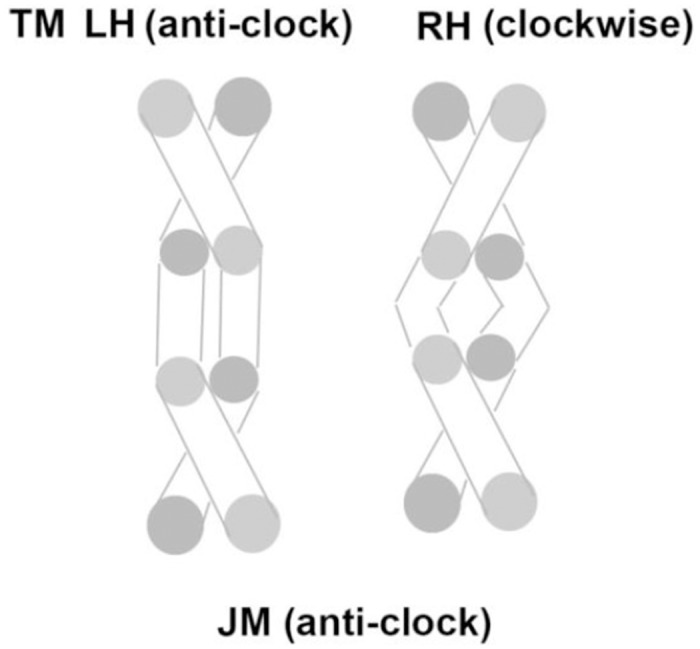
Schematic illustrating that structures with like-topology can be connected via straight segments, while unlike structures require some bending, either of irregular or of helical structures.